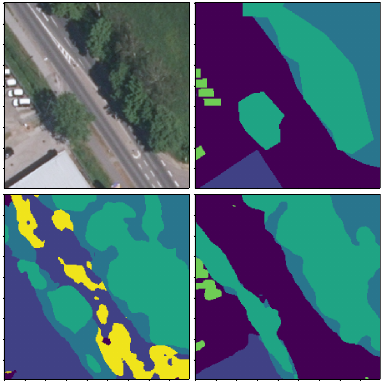
Figure 1. Using semantically paired images (bottom-right; our idea) enhances existing adaptation approaches (bottom-left) and brings them closer to the ground truth